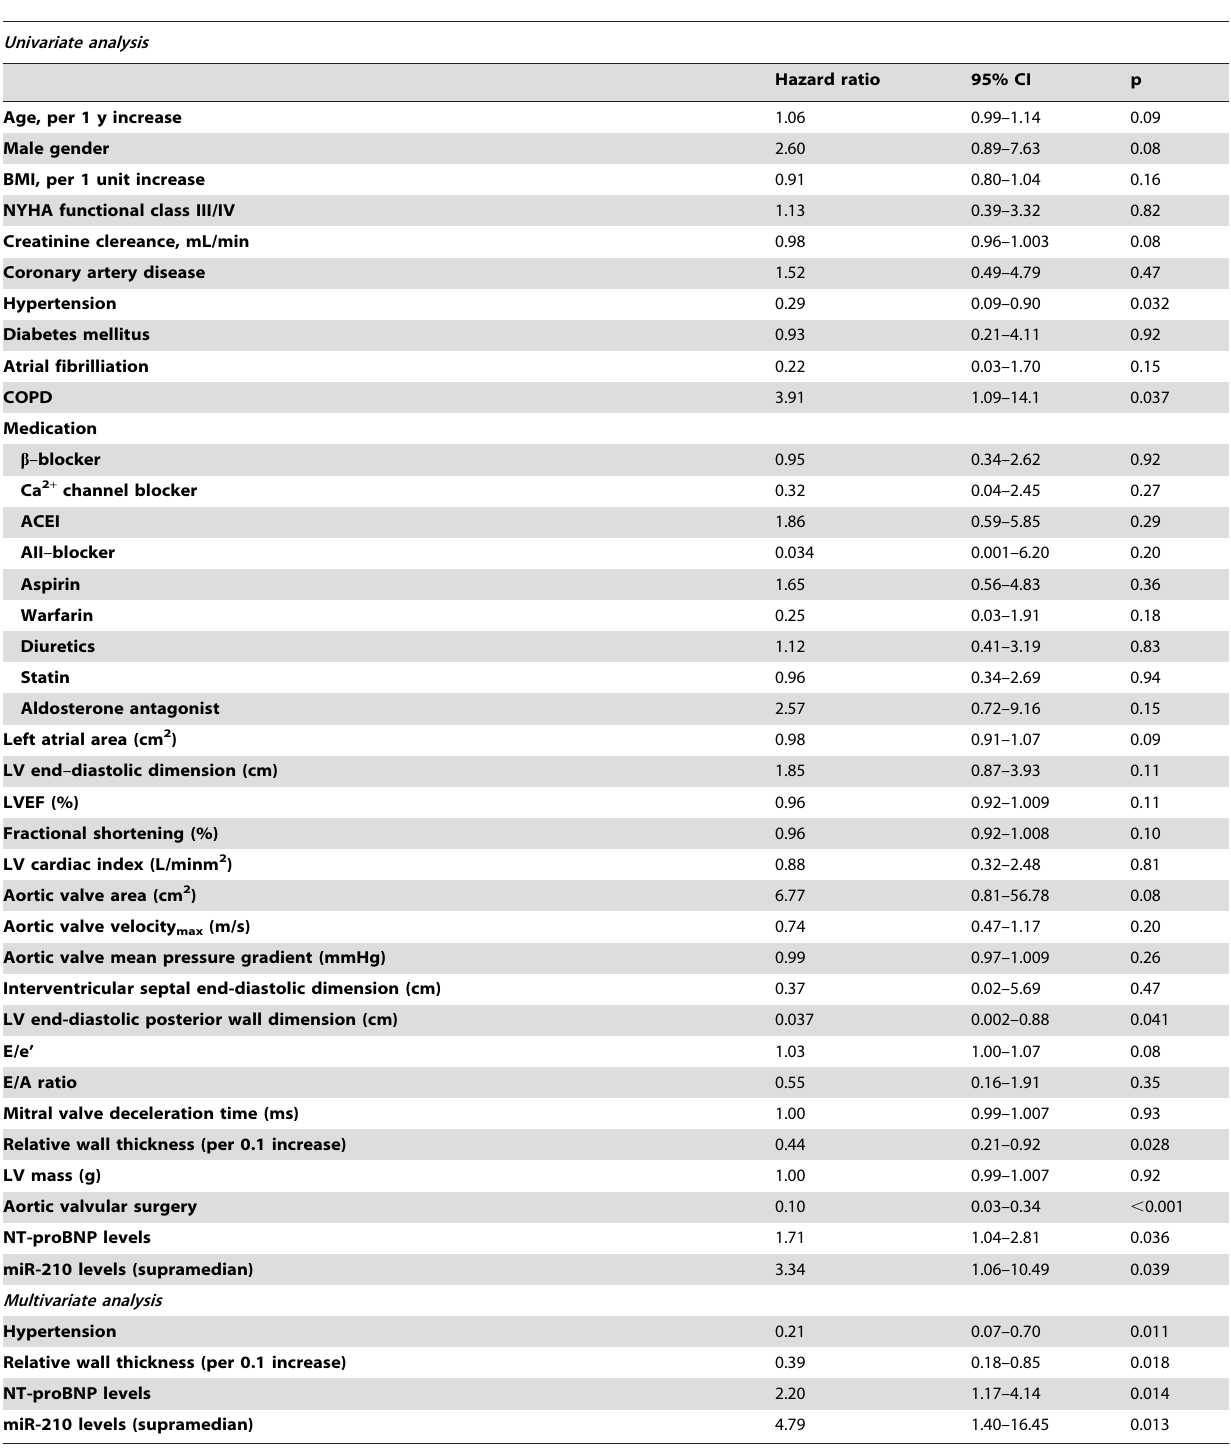
Table 4. Predictors for mortality during follow-up by univariate and multivariate Cox proportional hazard regression analysis.